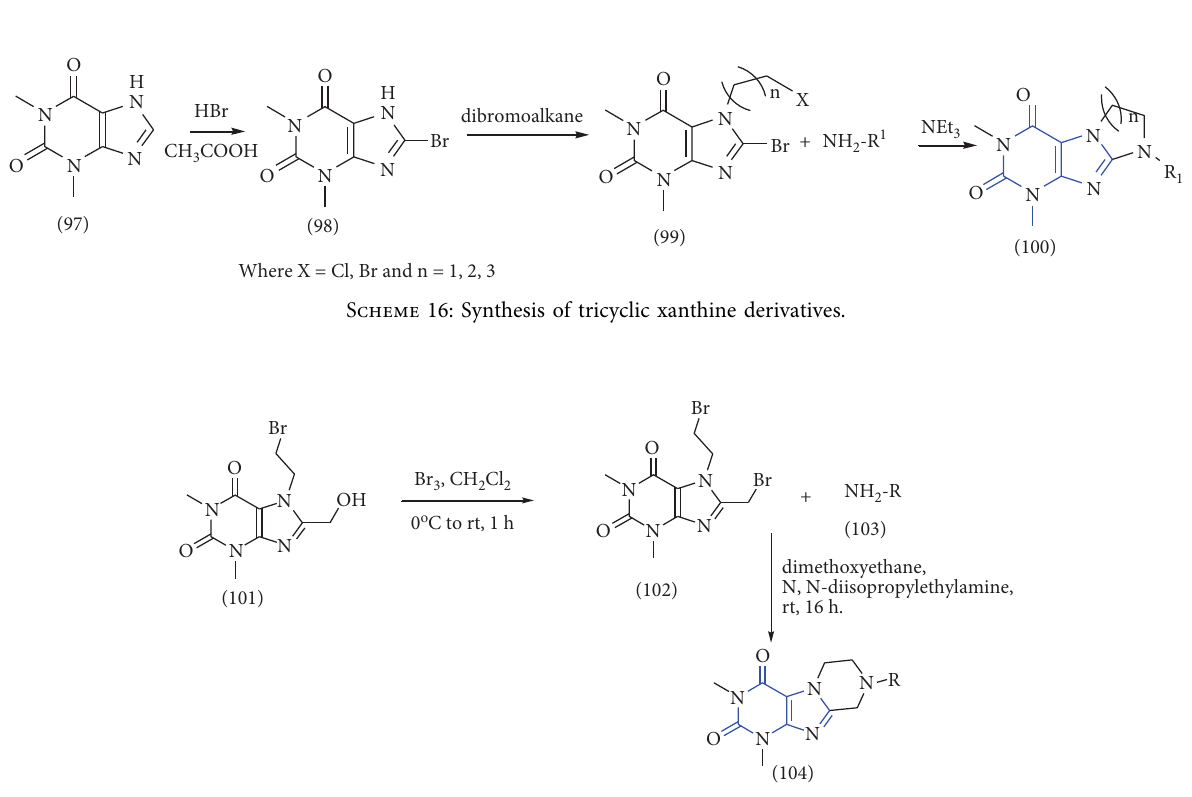
Scheme 15: Synthetic pathway towards 8-substituted-purine-2,4(1H,3H)-diones.